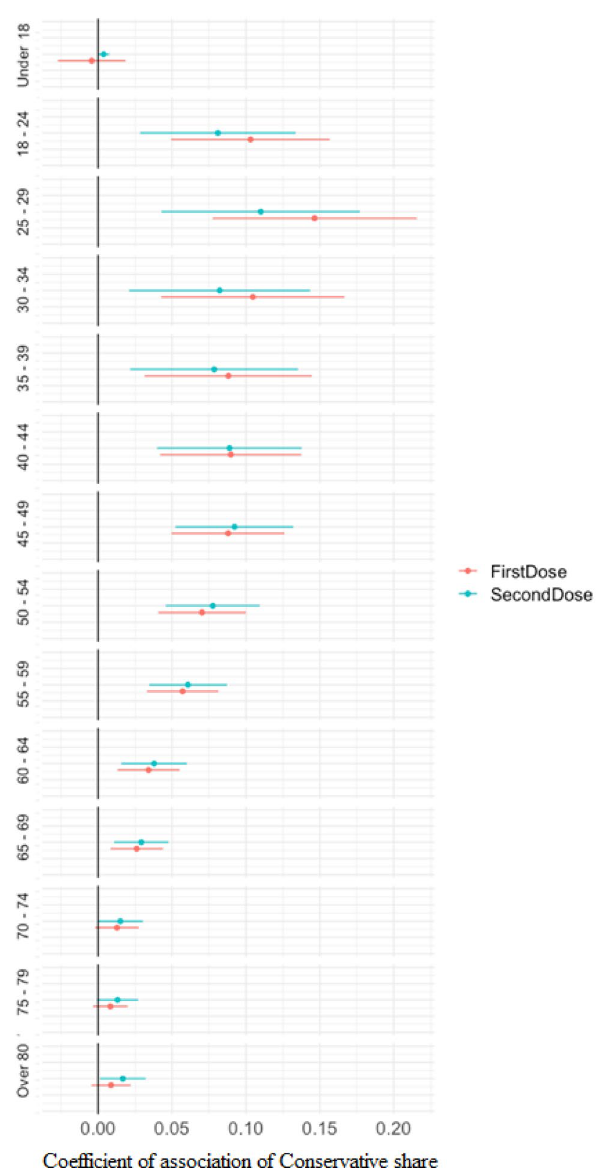
Figure 3. Vaccination for different age groups and conservative vote share. See notes of Fig. 2. Different colours capture results for first versus second dose vaccination rates,